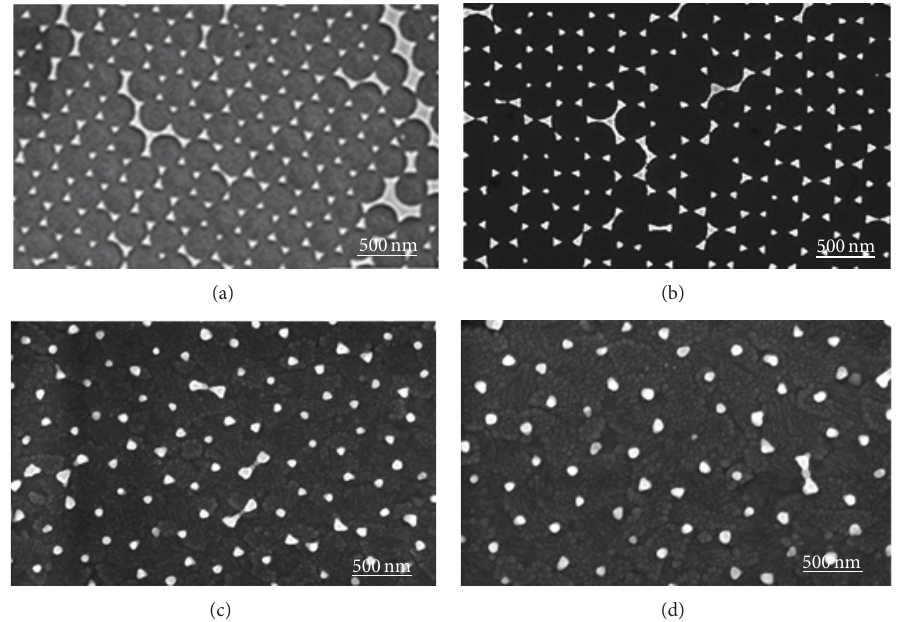
Figure 10: SEM images of the silver nanoarrays for different PS sphere sizes with fixed silver film thickness of 40 nm: (a) 230 nm, (b) 280 nm, (c) 380 nm, and (d) 460